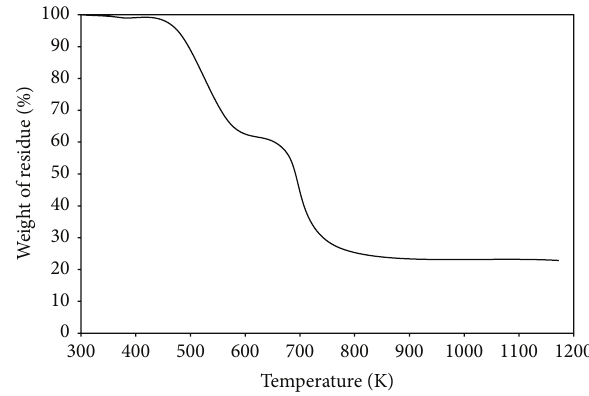
Figure 1: Thermogravimetric analysis